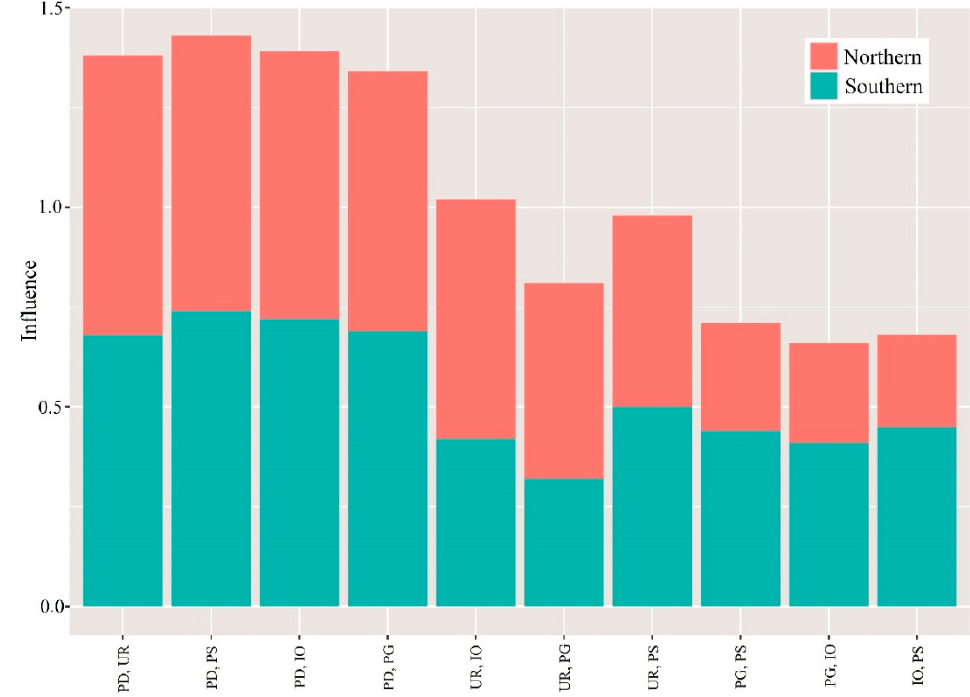
Figure 7. Interactions among socioeconomic factors in Northern and Southern China. Note: PD: population density, UR: the non-agricultural proportion of the population, PG: per capita gross domestic product, IO: industrial output, PS: proportion of secondary industry.